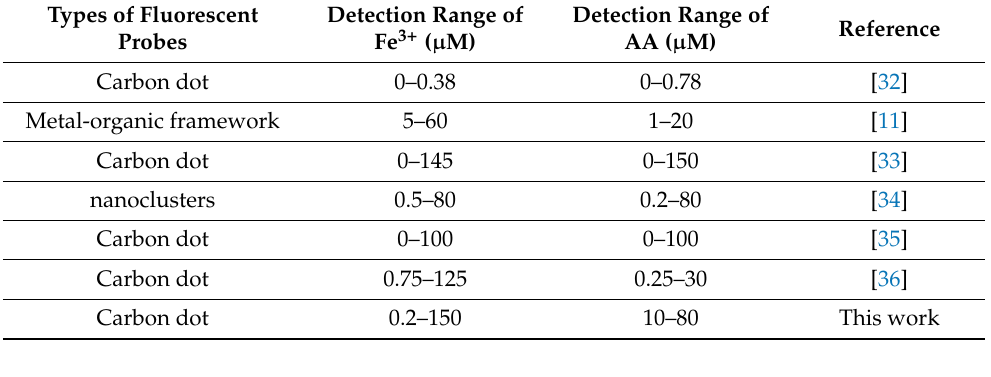
Table 1. Comparison of several fluorescent probes for Fe 3+ and AA described in recent reports.